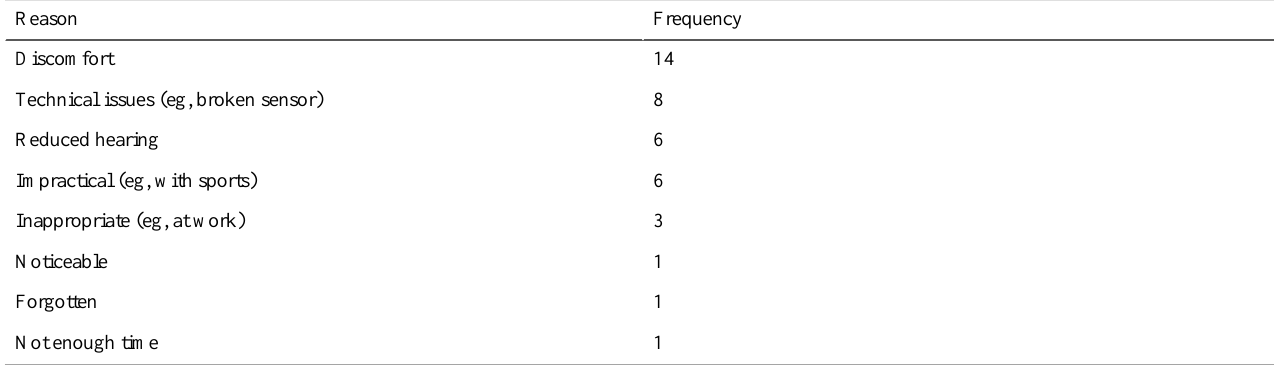
Table 1. Reasons mentioned for wearing the eating detection sensor <2 hours and their